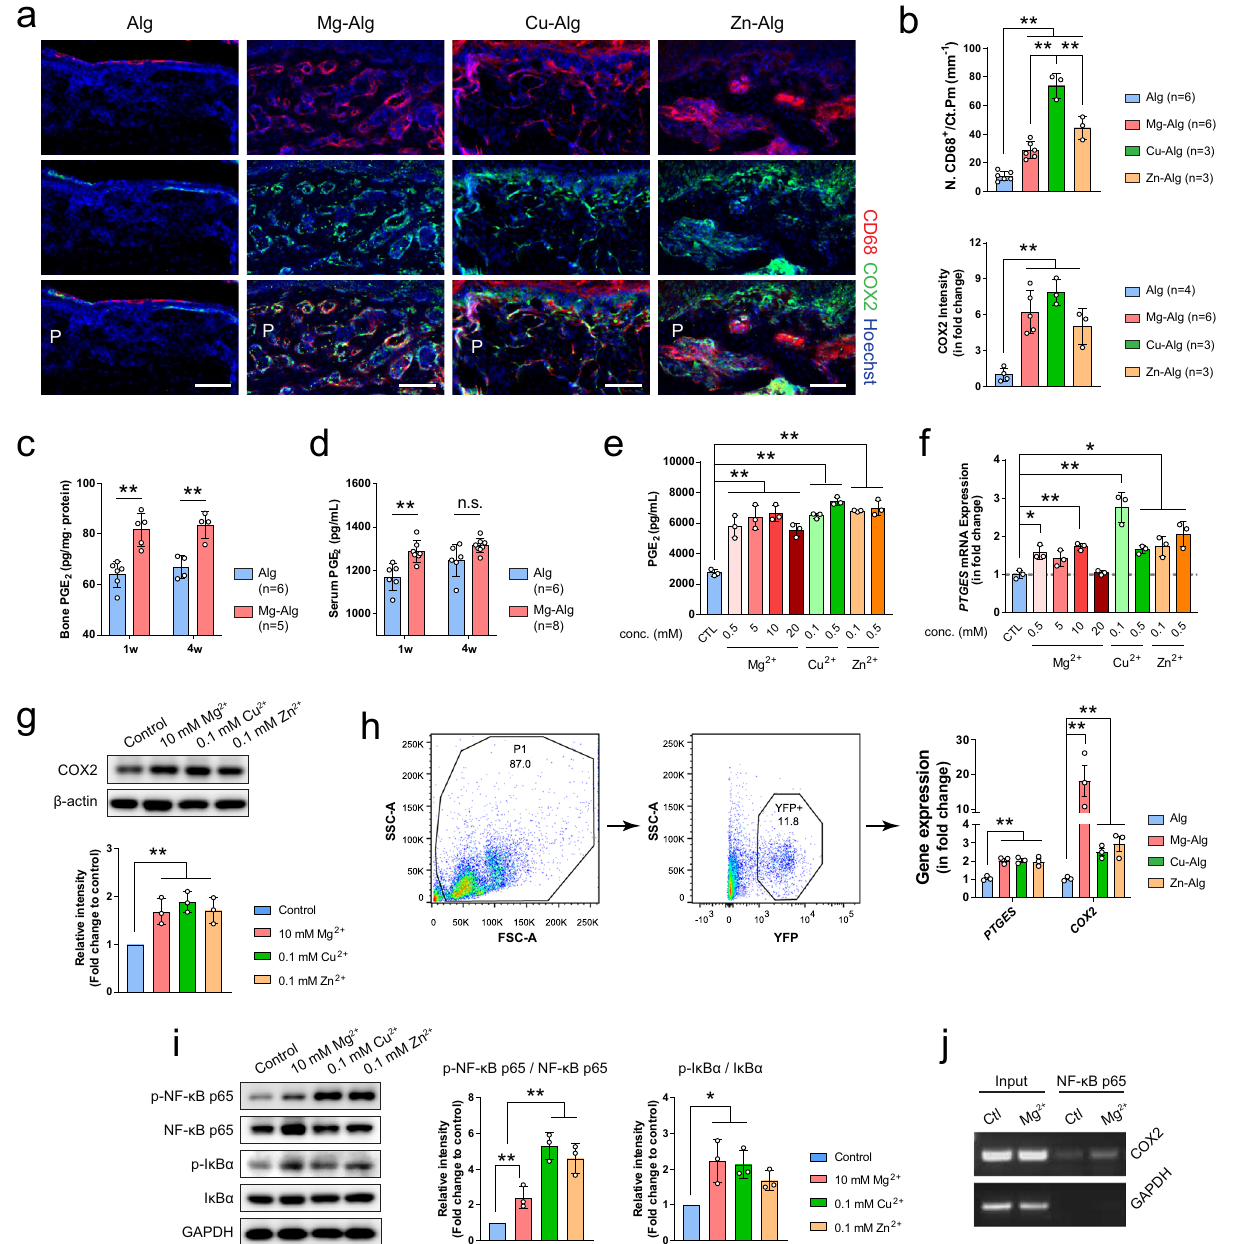
Fig. 2 Divalent cations stimulate secretion of prostaglandin E2 (PGE 2 ) by macrophages. a Co-immunostaining of cyclooxygenase-2 (COX2) with cluster of differentiation 68 (CD68) in the periosteum at week 1 postoperatively (scale bars = 100 µ m). b Quanti fi cation of macrophage numbers on the cortical bone surface and COX2 intensity in the periosteum at week 1 postoperatively. Enzyme-linked immunosorbent assay (ELISA) analysis of the bone ( c ) and serum ( d ) PGE 2 concentration at week 1 and week 4 postoperatively. e ELISA analysis ( n = 3) showing the effect of different concentrations of Mg 2 + , Zn 2 + , or Cu 2 + on the release of PGE 2 from bone marrow macrophages (BMM). f Real-time polymerase chain reaction analysis of PTGES mRNA expression in mouse BMM after 3-day incubation culture medium supplemented with different concentrations of Mg 2 + , Zn 2 + , or Cu 2 + ( n = 3). g Representative Western blots and corresponding quanti fi cation showing the effect of different divalent cations on the expression of COX2 in mouse BMM ( n = 3). h Gating strategies for fl ow cytometry sorting of YFP + macrophages and the RT-qPCR data showing PTGES and COX2 mRNA expression in macrophage at week 1 postoperatively ( n = 3). i Representative Western blots and corresponding quanti fi cation showing the effect of different divalent cations on the phosphorylation of NF- κ B and I κ B α in mouse BMM ( n = 3). j Chromatin immunoprecipitation assay showing that the NF- κ B p65 at the COX2 promoter was upregulated by the stimulation of Mg 2 + ( n = 3). Data are mean ± s.d. n.s. (nonsigni fi cant), * P < 0.05, ** P < 0.01 by one-way ANOVA with Tukey ’ s post hoc test ( b , e – i ) or two-way ANOVA with Tukey ’ s post hoc test ( c , d ). Source data are provided as a source data fi le.